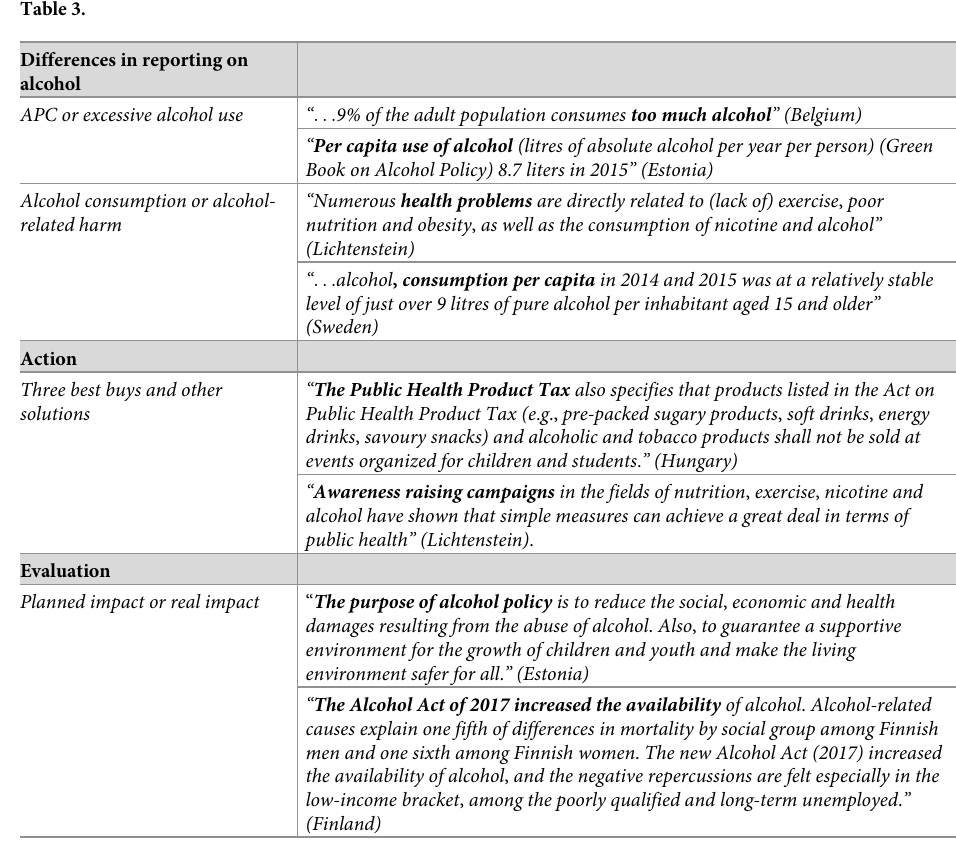
Differences in reporting on